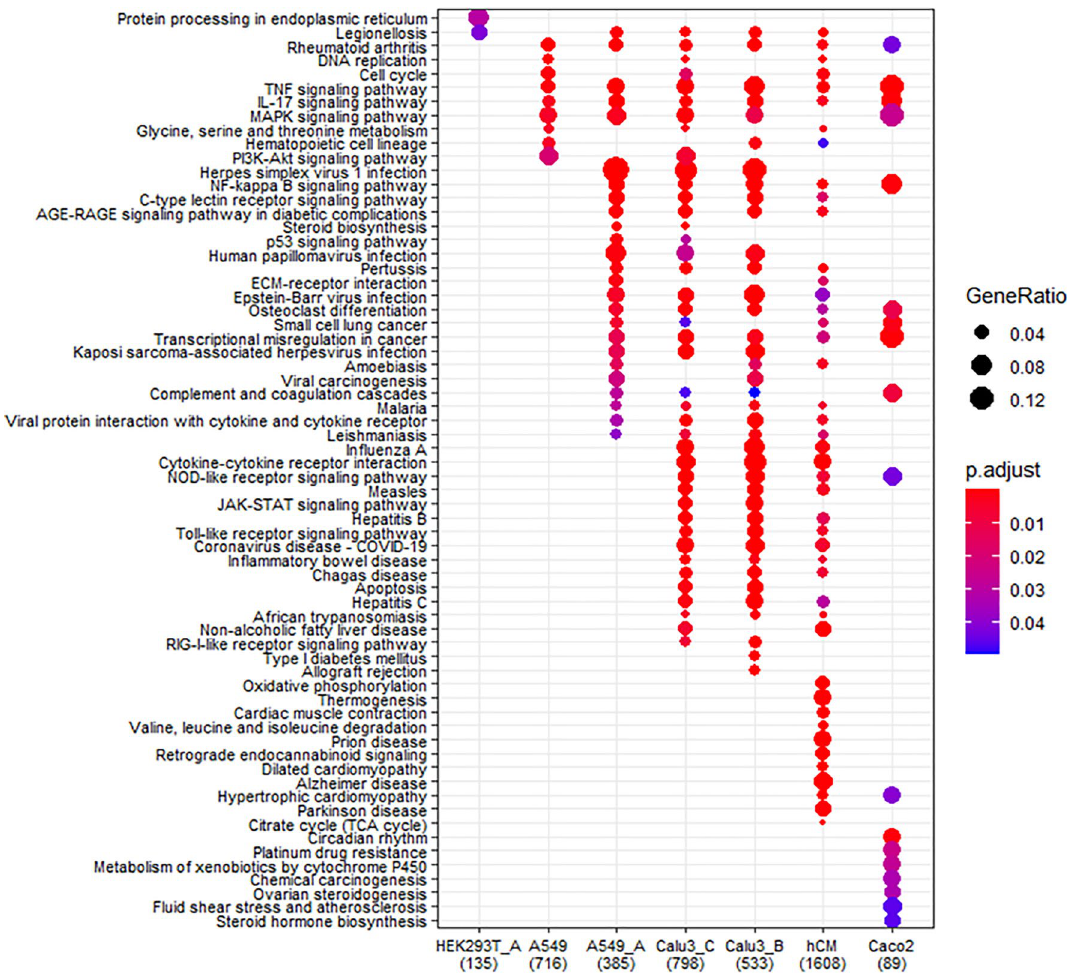
Figure 6. Comparison of GO enrichment analyses of DEGs with abs(log2FC) ≥ 1 and FDR < 0.05. DEGs in HEK293T-hACE2 (HEK293T_A), A549, A549-hACE2 (A549_A), Calu3_B, Calu3_C, hCM, and Caco2 cells. Calu3_B and Calu3_C represent data by Wyler E. (bioRxiv) and Blanco-Melo D. (Cell),